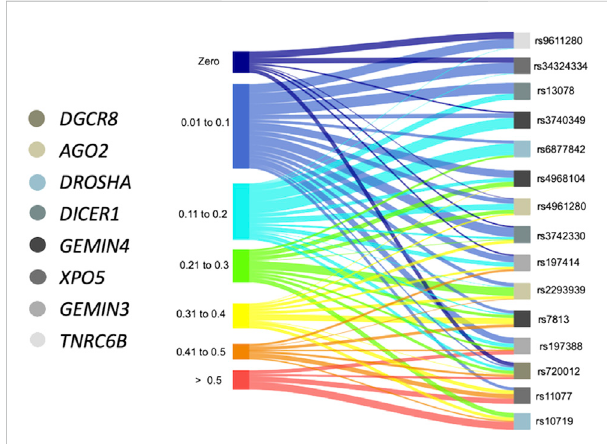
FIGURE 2 Variation in the frequency of the minor alleles in SNVs from components of the miRNA processing pathway in different ethnic groups. Sankey diagram showing the studied SNVs with connectors in different colors oriented towards the respective range of frequencies presented in 21 sub-continental populations from the 1,000 Genome project and theMEZ population from thisstudy. Boxes incolorbeloweachSNVcorrespondtothegeneinwhicheachvariant is located.